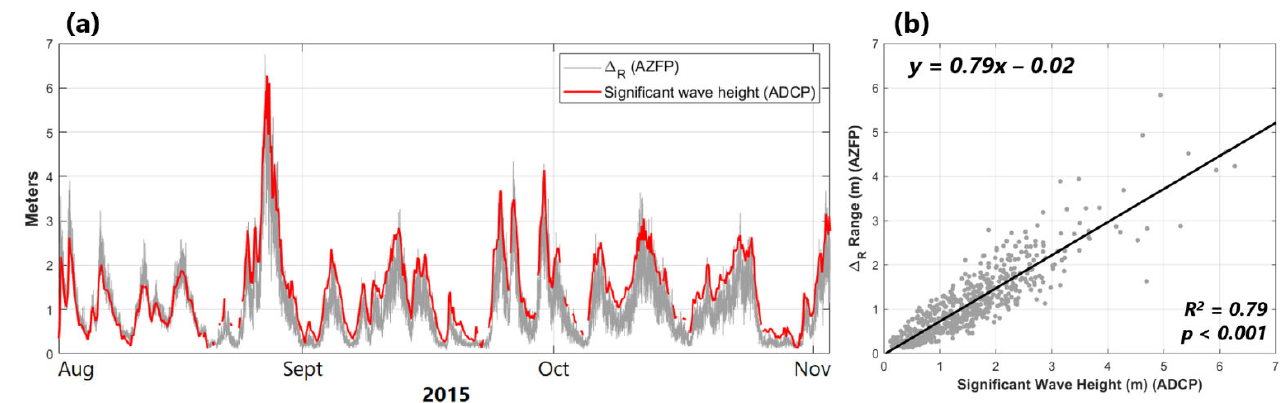
Figure 15. Time series ( a ) and scatter plot ( b ) of significant wave height and range of ∆ R for three months of the open-water season of 2015. Significant wave height was recorded by the ADCP installed on the one of the CEO moorings in the NE Chukchi Sea (in red), and range of ∆ R (15-min ensembles, in gray) is calculated from the AZFP, also from the CEO. The black line in ( b ) represents the least-squares best fit line; with accompanying correlation statistics are noted on the panel.